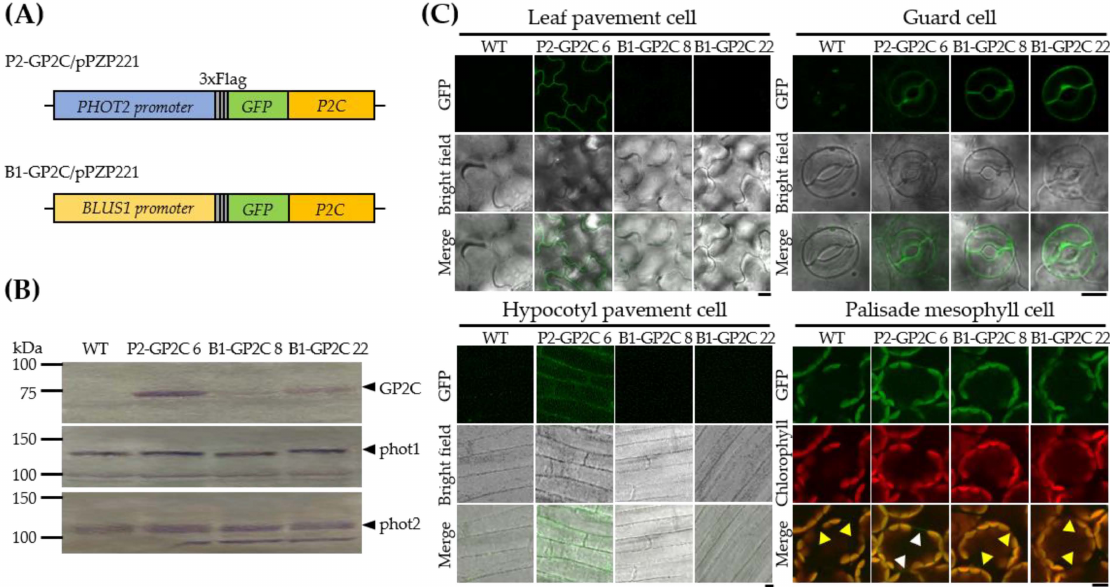
Figure 1. Production of P2-GP2C and B1-GP2C transgenic Arabidopsis plants. ( A ) Schematic dia- grams of the P2-GP2C and B1-GP2C expression vectors used for Agrobacterium -mediated Arabidopsis transformation. The detailed cloning procedures are discussed in the Material and Methods section. ( B ) Immunoblot analysis of P2-GP2C and B1-GP2C plants. Total proteins were extracted from the rosette leaves of 3-week-old WT, P2-GP2C, and B1-GP2C plants. The blots were probed with anti- Flag ( top ), anti-phot1 ( middle ), and anti-phot2 ( bottom ) antibodies, respectively. ( C ) Tissue-specific expression patterns of GP2C in P2-GP2C and B1-GP2C plants. GFP fluorescence was observed by confocal microscopy. Note that the fluorescent signals for GFP obtained from palisade mesophyll